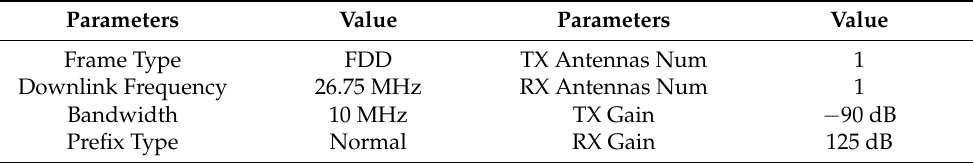
Table 3. The parameters of the base station in the prototyping